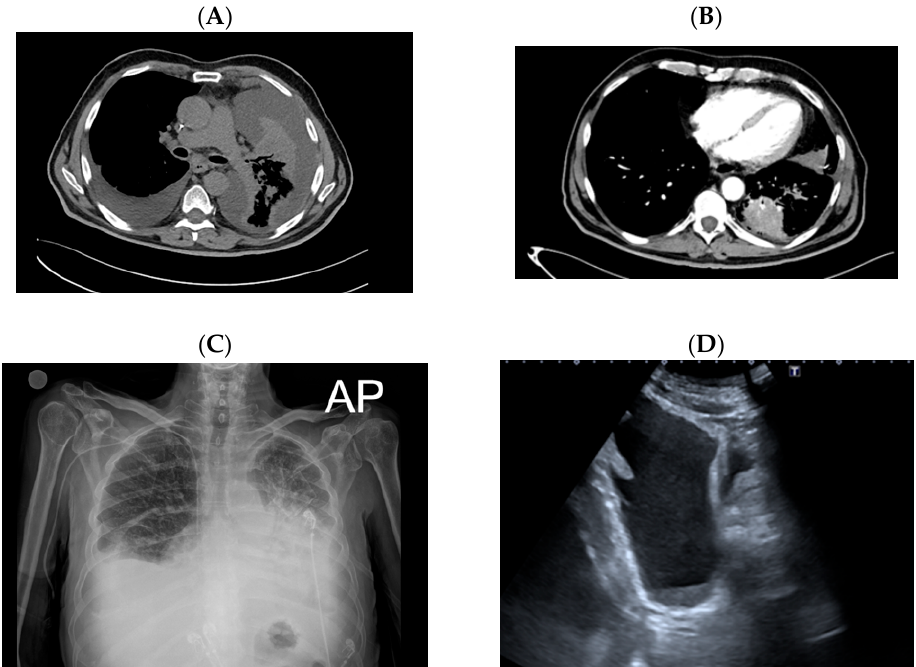
Figure 1. April 2021. ( A , B ) Computer tomography showing bilateral pleural effusions, a solid lesion of about 57 × 45 mm 2 with spiculated margins in the left lower lobe with carcinomatous lymphangitis. ( C ) Chest X-ray describing bilateral pleural effusion and synchronous carcinomatous lymphangitis. ( D ) Abdominal ultrasound highlighting pleural effusion.